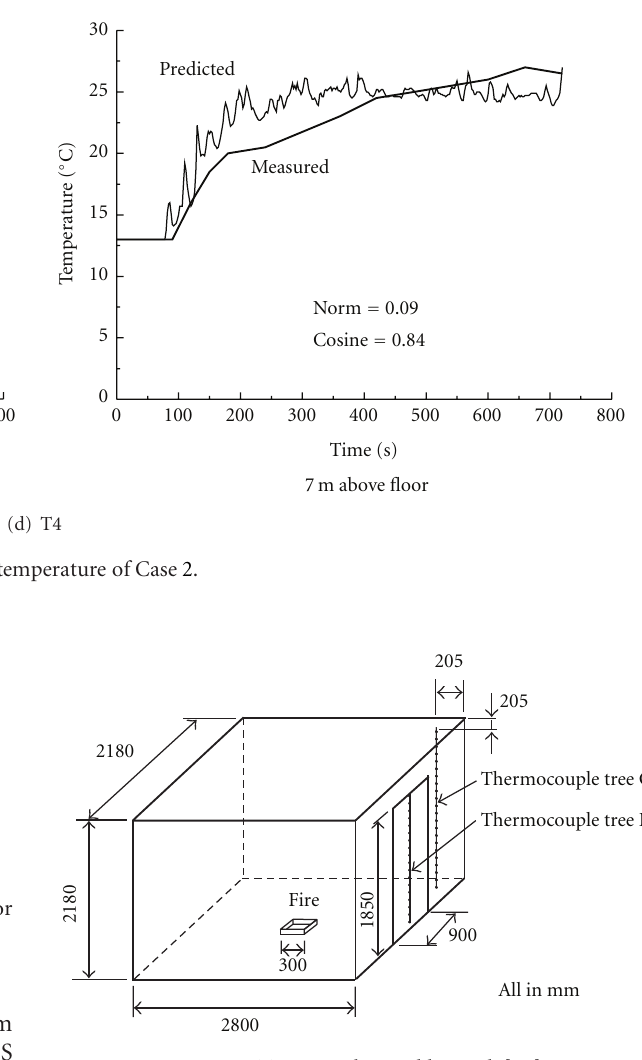
Figure 7: Test room by Steckler et al.